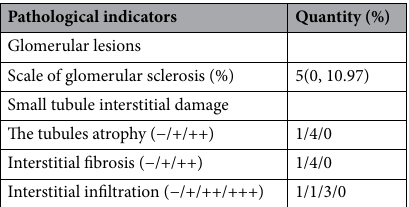
Table 3. General pathological data for patients with MN.